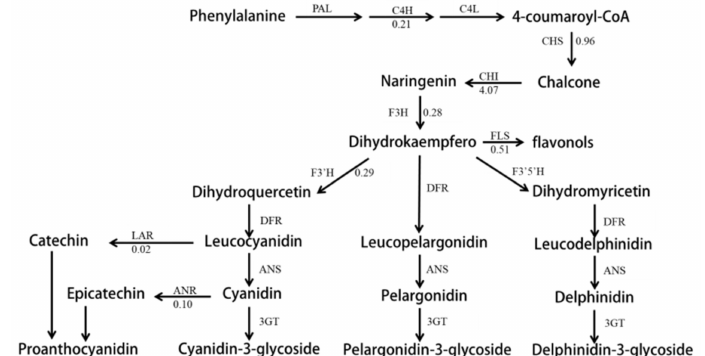
Figure 5. The differential expression of structural genes in the phenylalanine pathway. Arrows show the metabolic stream, left or upward arrows represent the genes catalyzing the progress, and the number represents the up-/down-regulation times of the genes in red pitayas as compared to white